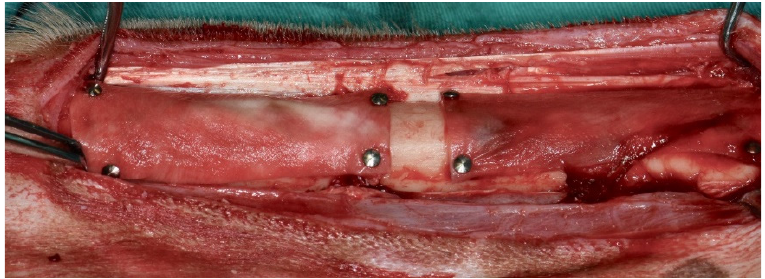
Figure 4. All of the defects surfaces were covered and pinned with collagen membrane.